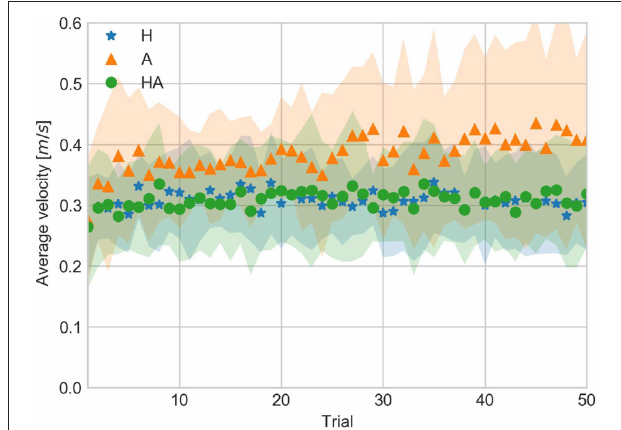
FIGURE 9 | Average velocity against trial number averaged over all subjects for the haptic (H), acoustic (A), and haptic-acoustic (HA) conditions. The contour represents the standard deviation.